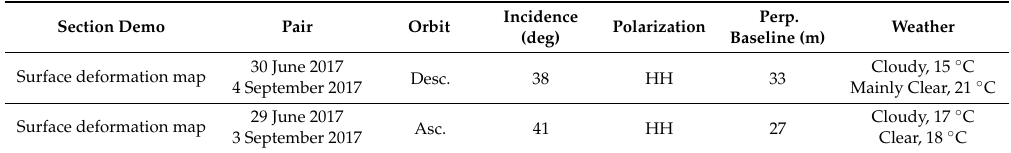
Figure 13. Boundary Range Slide: Geocoded TSX. ( a ) Descending orbit interferogram (30 June 2017–4 September 2017); ( b ) ascending orbit interferogram (29 June 2017–3 September 2017). The two areas where deformation is observed are highlighted in red, and the zoom insets and the scales are also presented. Table 5. Boundary Range Slide presented